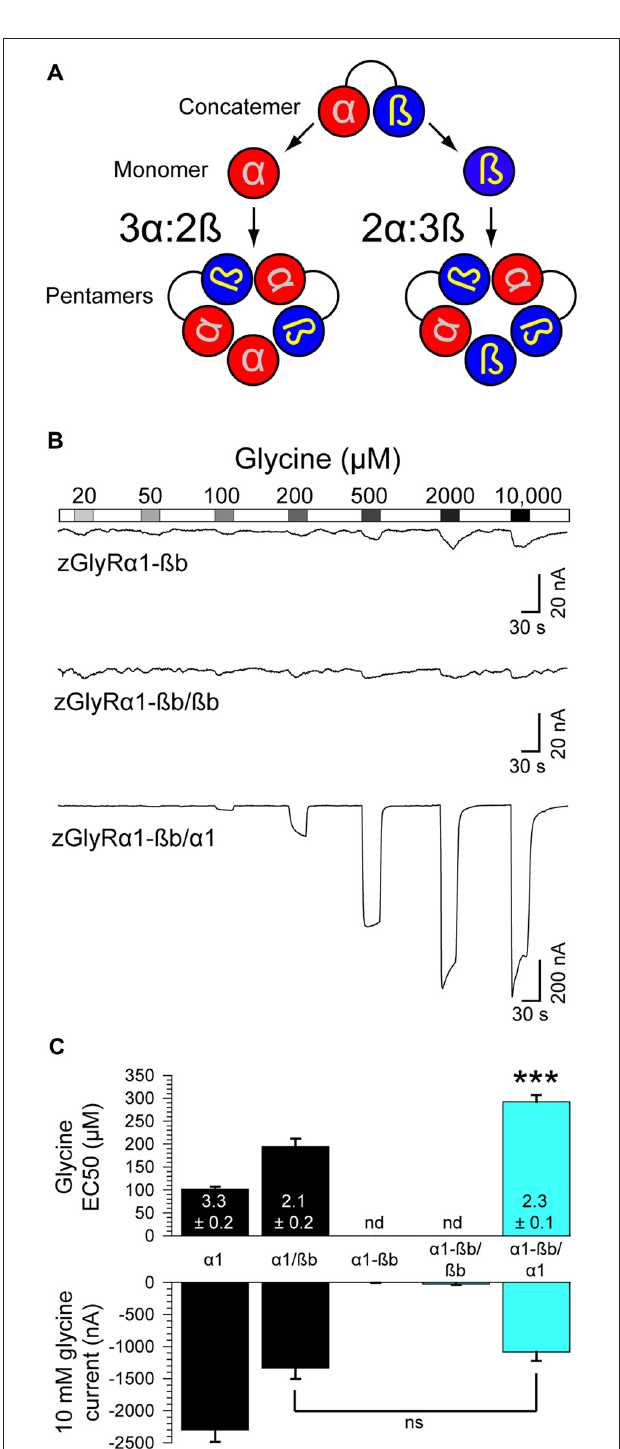
FIGURE 8 | Heteromeric zGlyRs assemble with a stoichiometry of 3 α :2ß. (A) Schematic detailing the assembly of pentameric zGlyRs from concatemers and either monomeric zGlyR α 1 or zGlyRßb. (B) Two-electrode voltage clamp recordings from oocytes injected with cRNA encoding concatemers alone, or with monomeric zGlyR α 1 or zGlyRßb cRNA. Note that the current scale bars on the top and middle traces differ from the bottom trace. (C) Average glycine EC 50 and responses to 10 mM glycine ( n = 10). ∗∗∗ p <